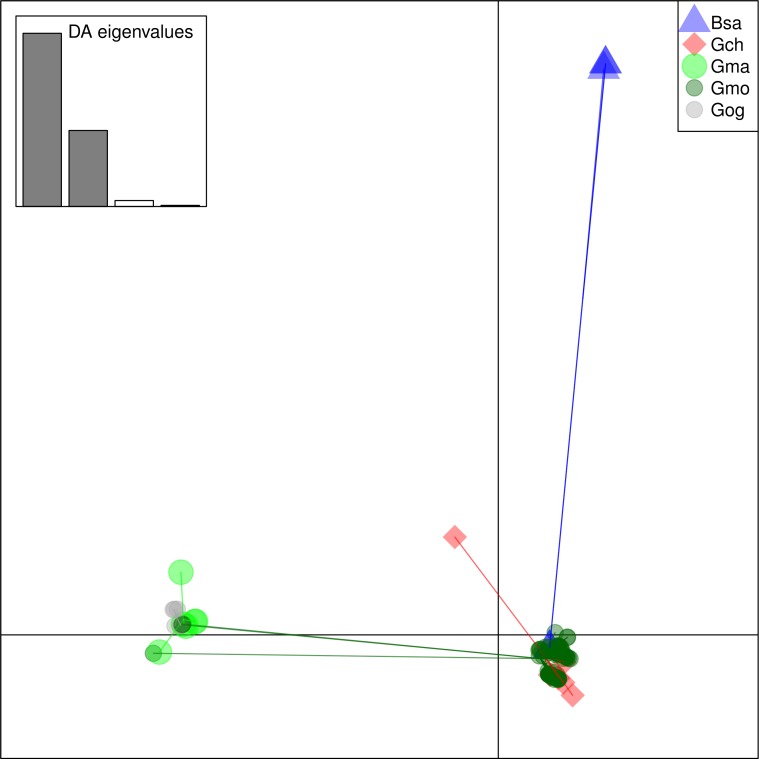
Discriminant Analysis of Principle Components (DAPC) scatterplot of the five species clusters.Ten principle components and three discriminant functions were retained in the analysis. Scatterplot of the first two disciminant functions with eigenvalues used in black. The species are represented as dots of different shapes and colors representing the a priori groups of species: Bsa (Boreogadus saida), Gch Gadus chalcogrammus, Gma Gadus macrocephalus, Gmo Gadus morhua, and Gog Gadus ogac.